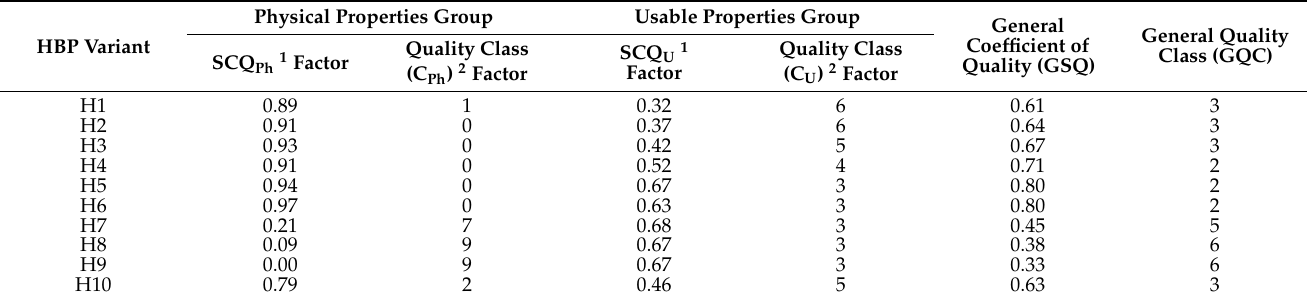
Table 7. Selection of optimal variants of the two-components HBP.